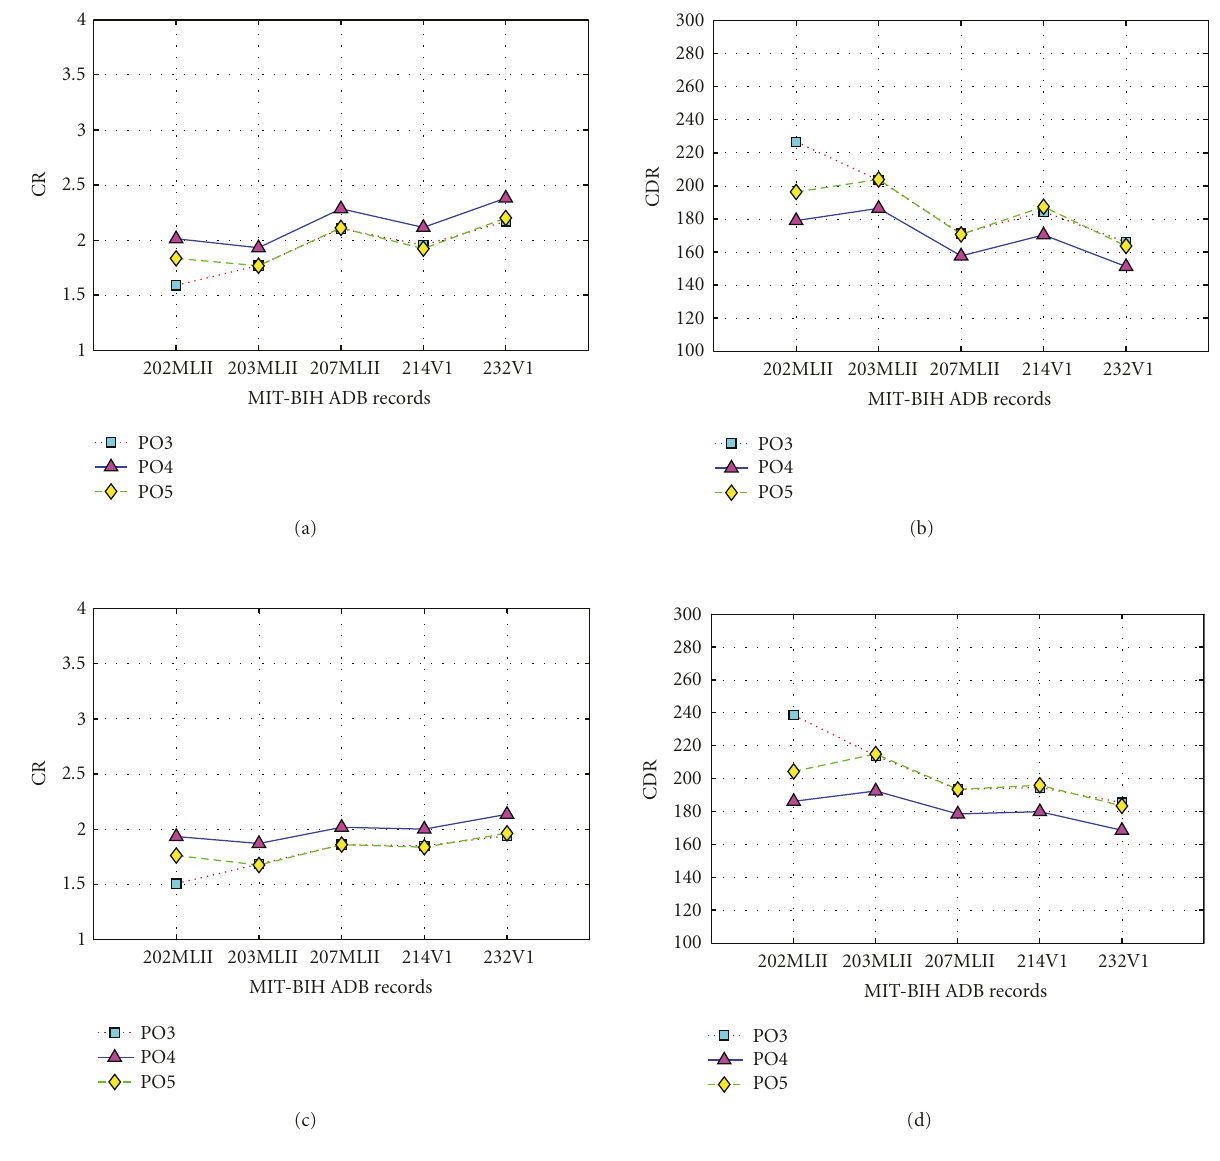
Figure 7: Compression e ffi ciency performance results on short-duration datasets with di ff erent predictor orders: (a) CR and (b) CDR for PA scheme, (c) CR and (d) CDR for PRA